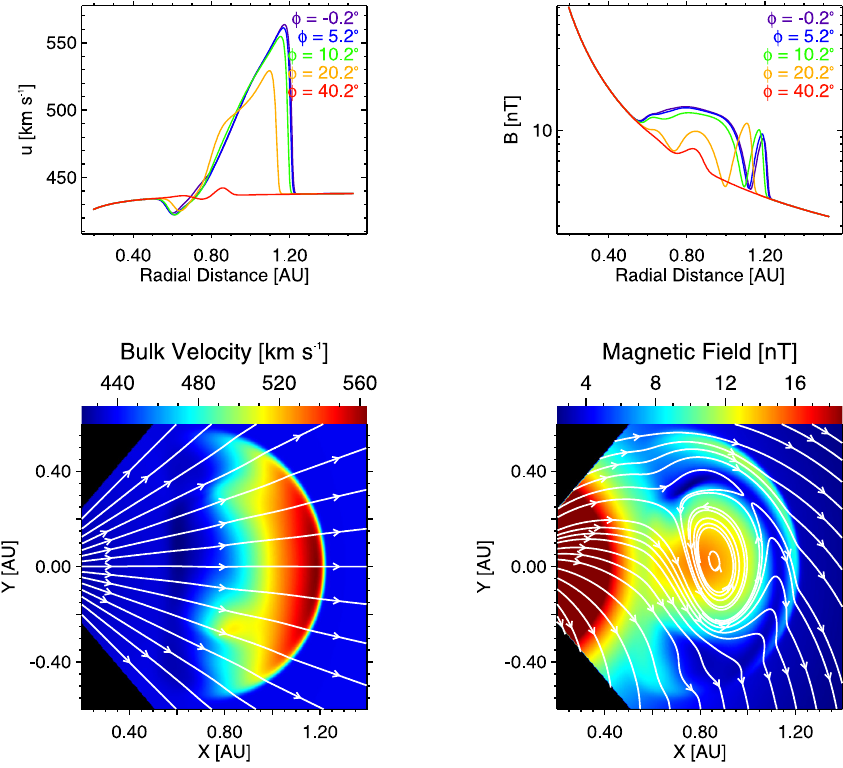
Fig. 4. Velocity (left) and magnetic field (right) for the H + e magnetic cloud near